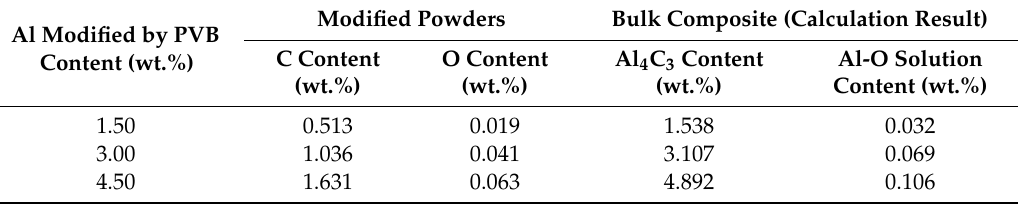
Table 1. C and O content of the modified powder and calculated quantity of Al-O solution and Al 4 C 3 in the